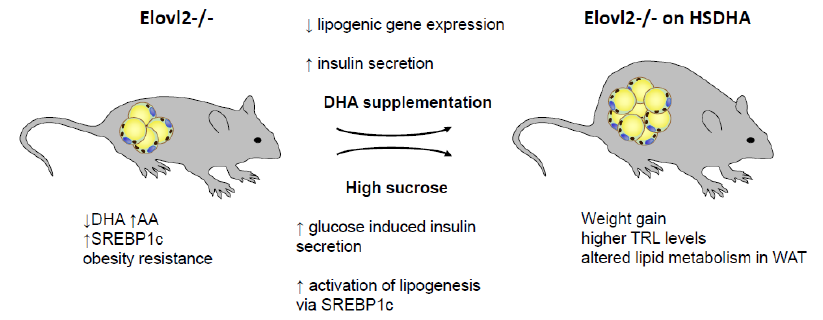
Figure 9 . High sucrose together with DHA supplementation affect lipid metabolism in Elovl2 -/- mice are characterized by low levels of DHA and resulting increases in the levels of arachidonic acid (AA). On an obesogenic diet, these animals show resistance to diet-induced obesity. These mice were fed a DHA-enriched diet (reducing lipogenic gene expression and at the same time increasing insulin secretion) containing high levels of sucrose (resembling human diet; also, leading to increased insulin levels and at the same time activating lipogenesis). This treatment of Elovl2 -/- mice resulted in a loss of the protection against diet-induced obesity, increased plasma TRL levels, and led to altered expression of key players in metabolic control in adipose tissue . Figure S1: Intestinal lipid uptake test, Figure S2: Fasting glucose concentration in blood, Figure S3: Parameters of lipid metabolism in the blood, Table S1: Primer sequences, Table S2: Apparent food absorption efficiency.